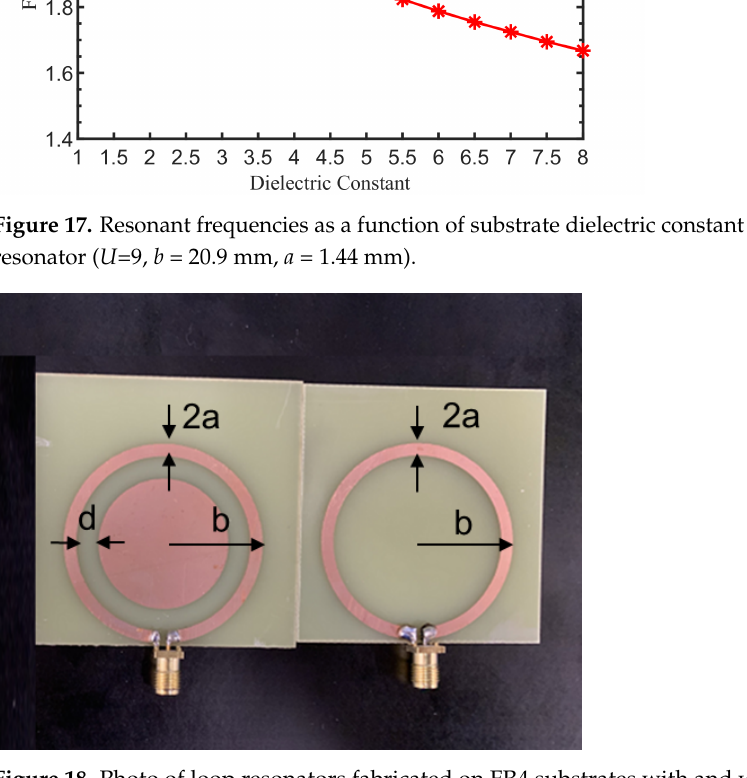
Figure 18. Photo of loop resonators fabricated on FR4 substrates with and without a tuning center pad. U =9, b = 20.9 mm, a = 1.44 mm, and d = 4.85 mm.